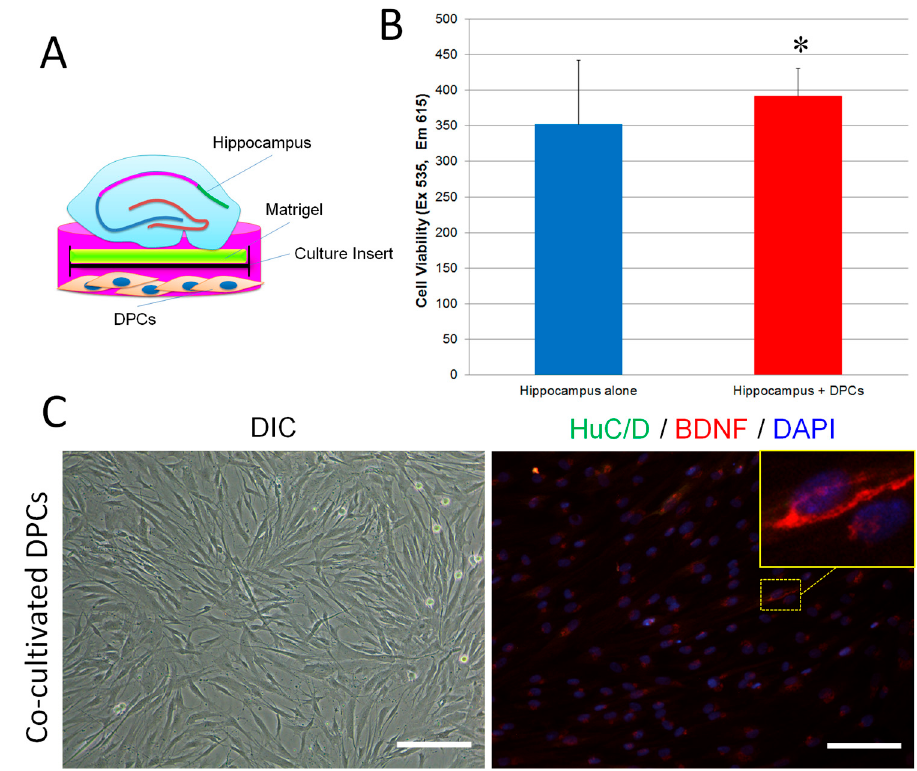
Figure 6. DPCs promoted cell growth in adult mouse hippocampal slices in vitro and expressed BDNF. ( A ) Experimental setup; ( B ) Adult hippocampal slices were cultivated on matrigel-coated culture inserts (5 slices/well) with or without DPCs for 17 days. The culture inserts were transferred into new 6-well plates and followed by presto blue assay. Data are presented as mean ± SD. * p < 0.05; ( C ) DPCs kept fibroblast morphology while co-cultivated with hippocampal slices (left, magnification = 20×). Immunofluorescence staining showed that some DPCs were positive to anti-BDNF antibodies. The expression of HuC/D was hardly detected in co-cultivated DPCs (right, magnification = 20×). Scale bar = 50 µm